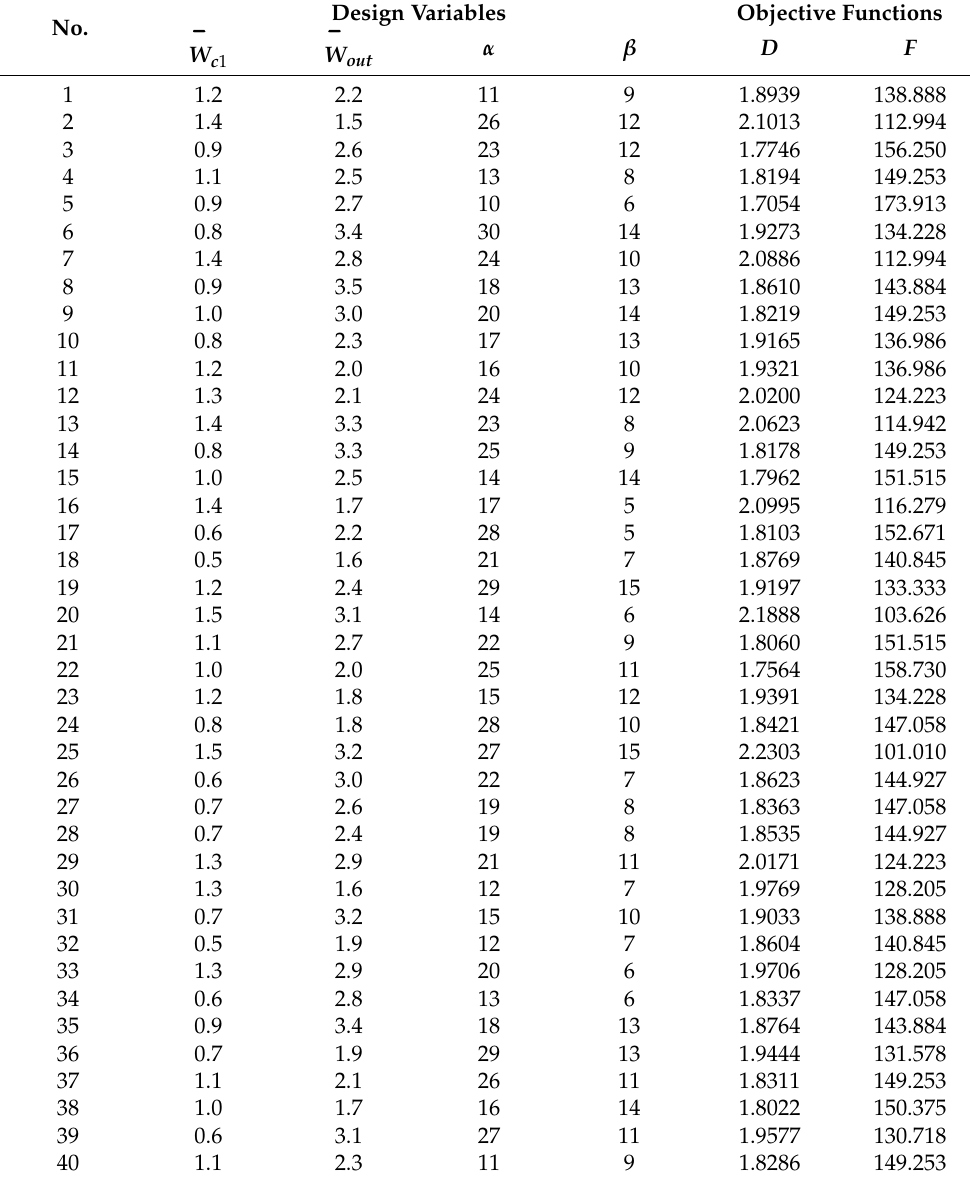
Table A1. Latin hypercube sampling method for generating 40 data samples within